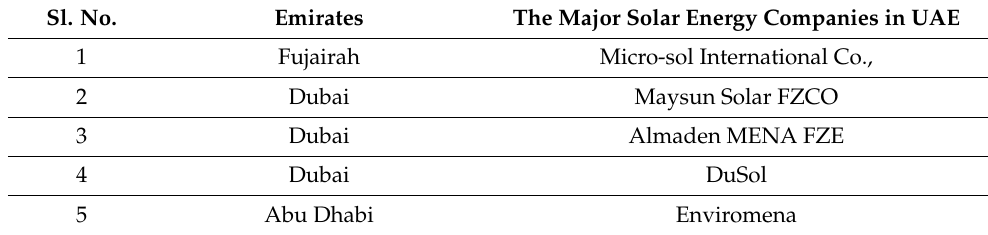
Table 5. List of major solar energy industries in the UAE’s seven emirates. Sl.